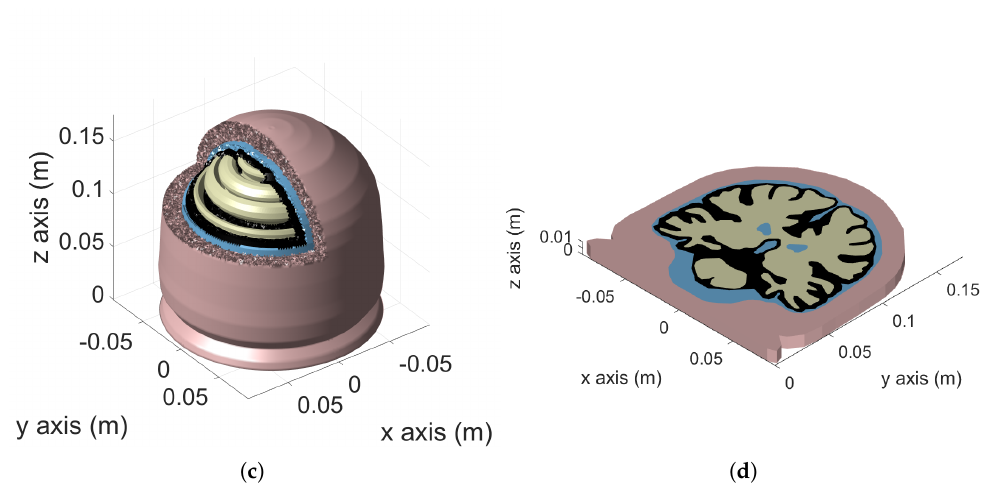
Figure 4. Colin27 Average Brain: 3D model ( a ), 2D cut-plane ( b ), axisymmetric model ( c ) and planar model ( d